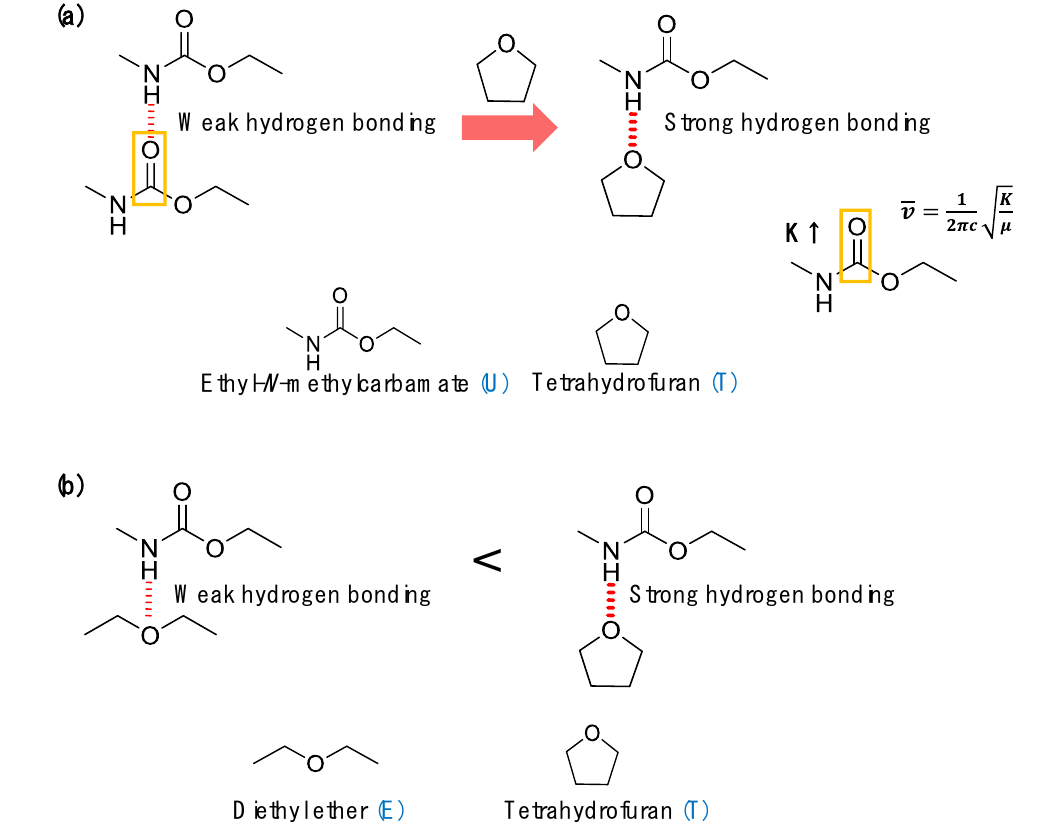
Figure 4. Schematic illustrations of: ( a ) the hydrogen bonding between two urethane groups (Us) and the hydrogen bonding between the urethane group (U) and the heterocyclic group (T) and ( b ) the hydrogen bonding between the urethane group (U) and the heterolinear group (E) and that between the urethane group (U) and the heterocyclic group (T).